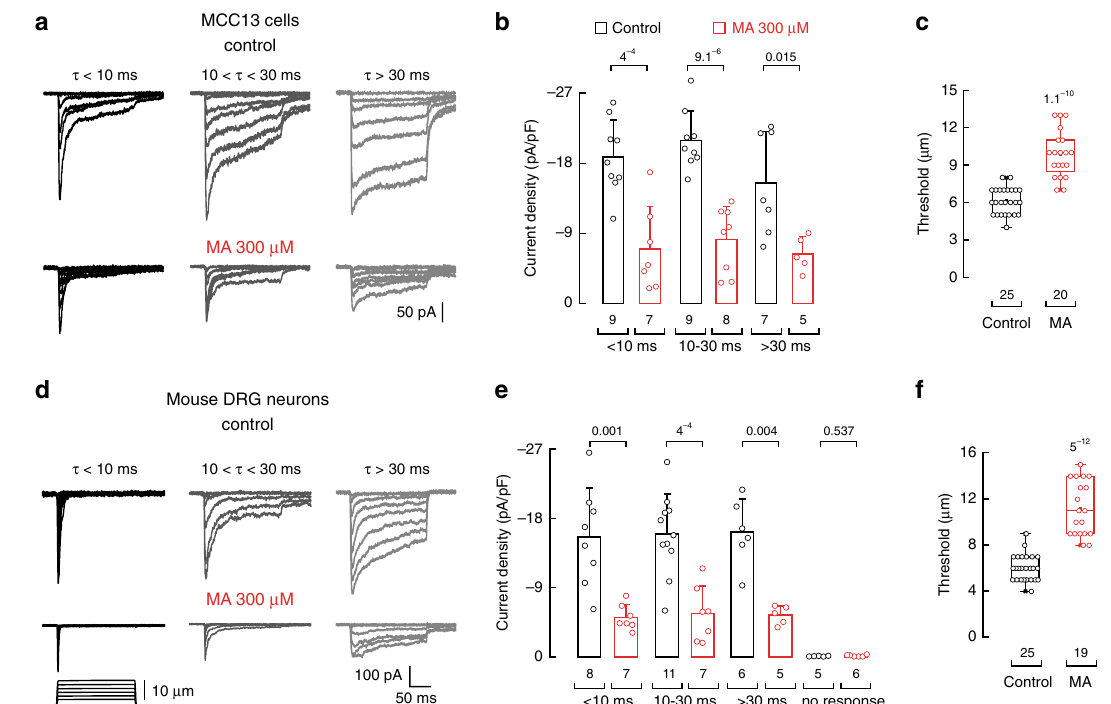
Fig. 3 MA decreases mechano-activated currents in MCC13 and mouse DRG neurons. a Representative whole-cell patch-clamp recordings elicited by mechanical stimulation (at − 60 mV) of rapidly ( τ < 10 ms), intermediate (10 < τ < 30 ms), and slowly inactivating ( τ > 30 ms) currents of control (top) and MA (300 µ M)-treated (bottom) MCC13. b Current densities elicited by maximum displacement of control and MA (300 µ M)-treated MCC13 cells. Bars are mean ± SD. n is denoted above the x -axis. Two-tailed unpaired t -test. c Displacement thresholds required to elicit mechano-currents of control and MA (300 µ M)-treated MCC13 cells. Boxplots show mean (square), median (bisecting line), bounds of box (75 th to 25 th percentiles), outlier range with 1.5 coef fi cient (whiskers), and minimum and maximum data points. n is denoted above the x -axis. Two-tailed unpaired t -test. d Representative whole-cell patch-clamp recordings elicited by mechanical stimulation (at − 60 mV) of rapidly ( τ < 10 ms), intermediate (10 < τ < 30 ms), and slowly inactivating ( τ > 30 ms) currents of control (top) and MA (300 µ M)-treated (bottom) DRG neurons. e Current densities elicited by maximum displacement of control and MA (300 µ M)-treated DRG neurons. Bars are mean ± SD. n is denoted above the x -axis. Two-tailed unpaired t -test. f Displacement thresholds required to elicit mechano-currents of control and MA (300 µ M)-treated DRG neurons. Boxplots show mean (square), median (bisecting line), bounds of box (75 th to 25 th percentiles), outlier range with 1.5 coef fi cient (whiskers), and minimum and maximum data points. n is denoted above the x -axis. Two-tailed unpaired t -test. p -values are denoted above the bars and